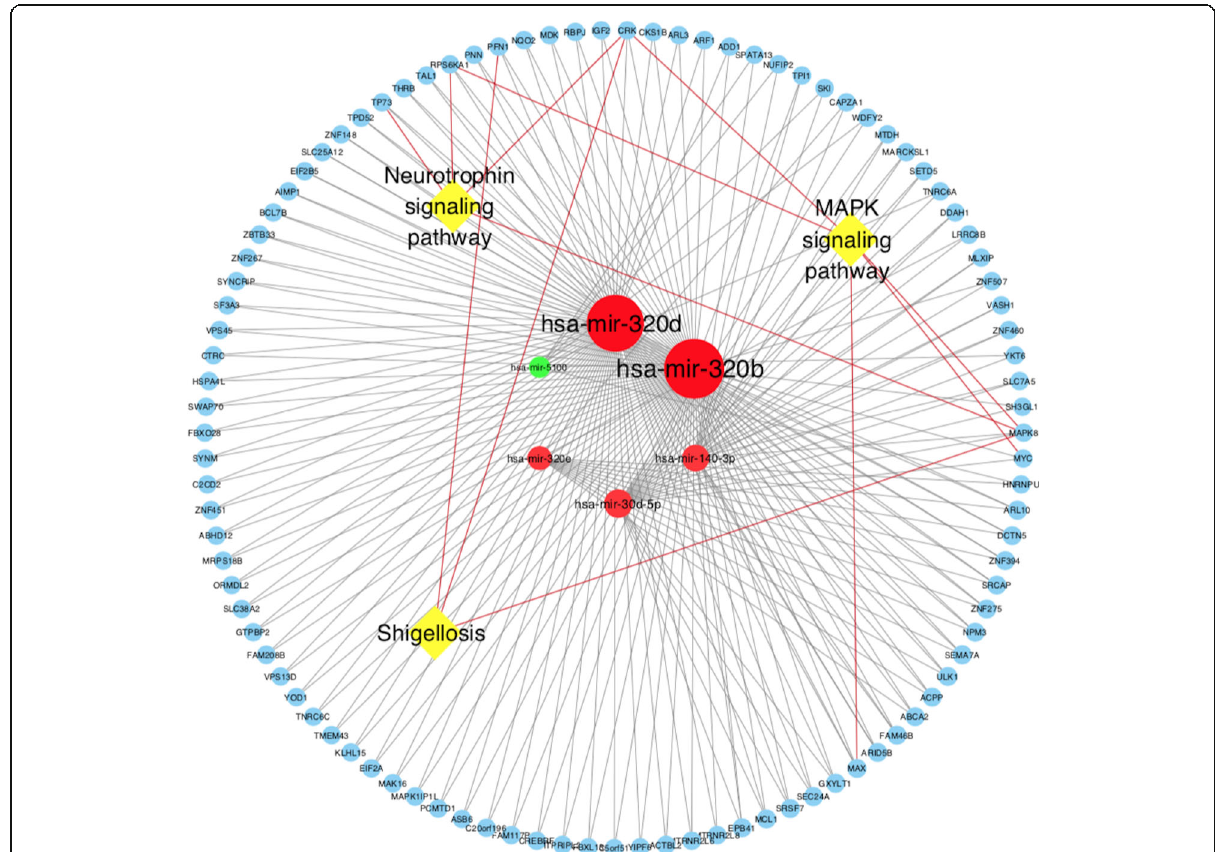
Fig. 9 Outline of the interactions among the significant KEGG pathways, DE genes and